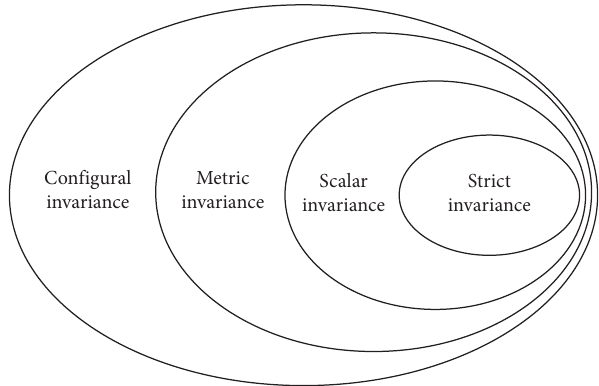
Figure 1: The relationship between the four levels of measurement